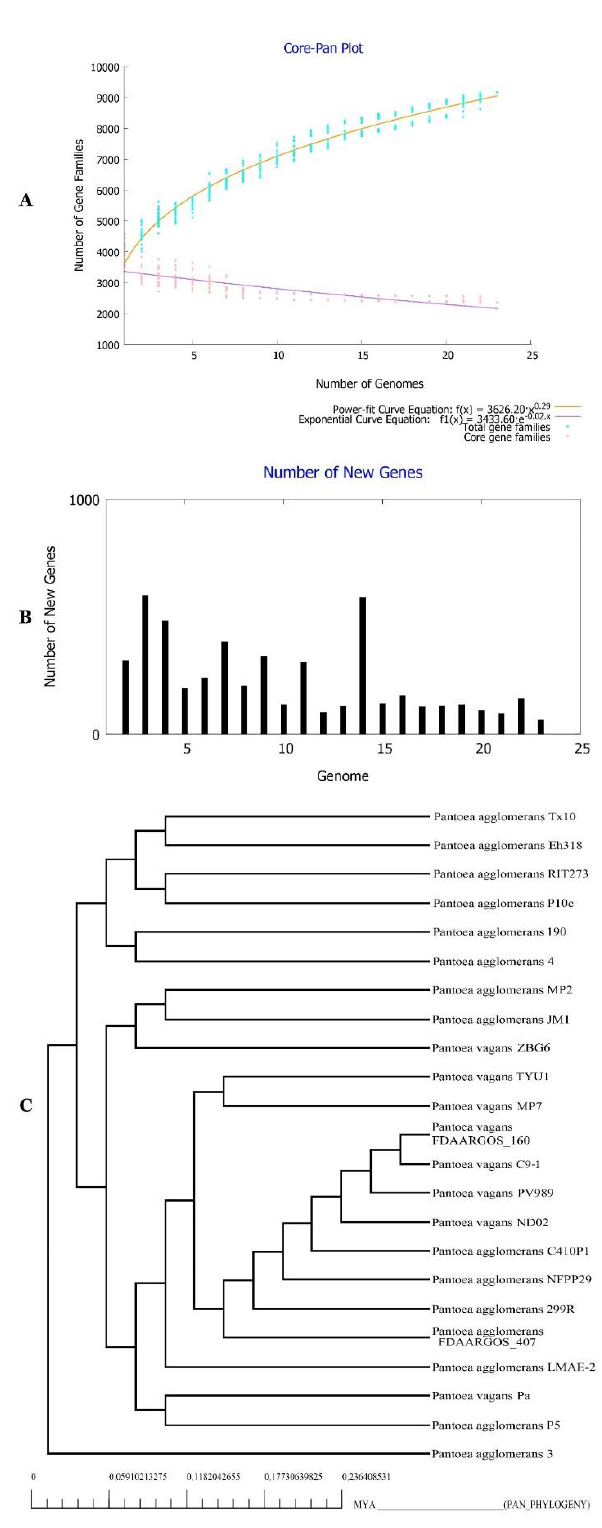
Figure 12. ( A ) Core–pan genome plot of P. agglomerans and P. vagans strains based on number of gene families and genomes. ( B ) New genes discovered in bacterial genomes. ( C ) Tree of Pan-genome of the bacterial strains.